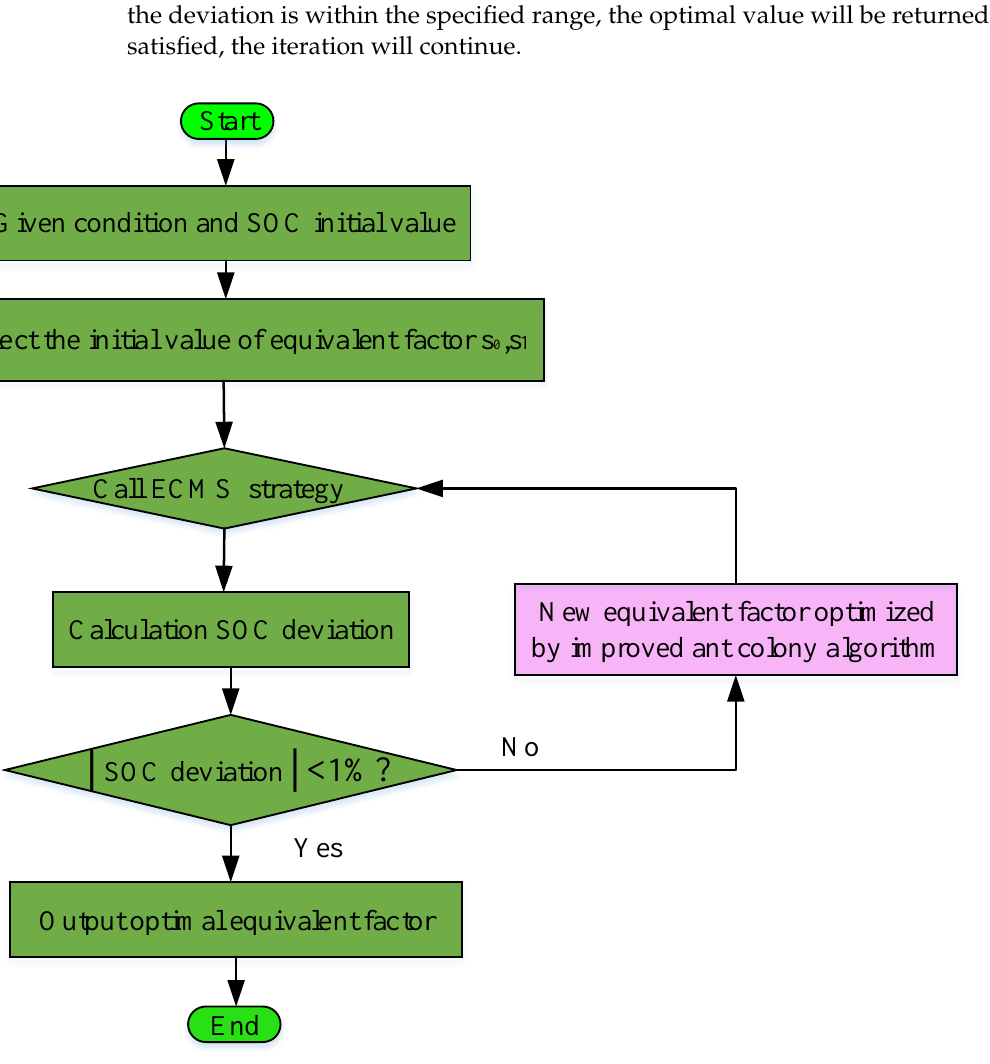
Figure 8. Optimal equivalent factor solution process.